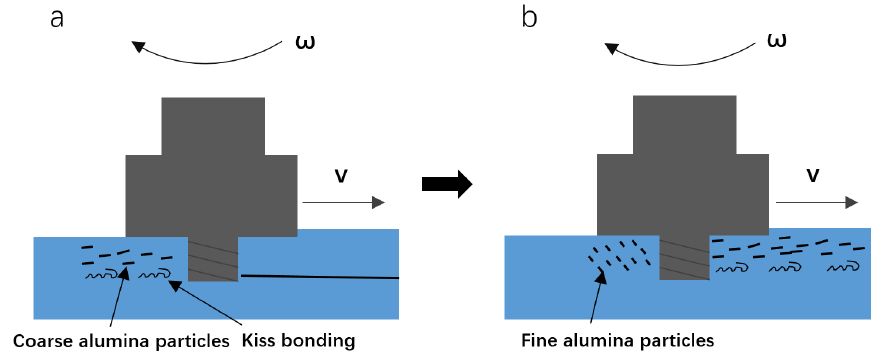
Figure 7. Schematic of two-pass processing for defect elimination: ( a ) first processing and ( b ) second processing.